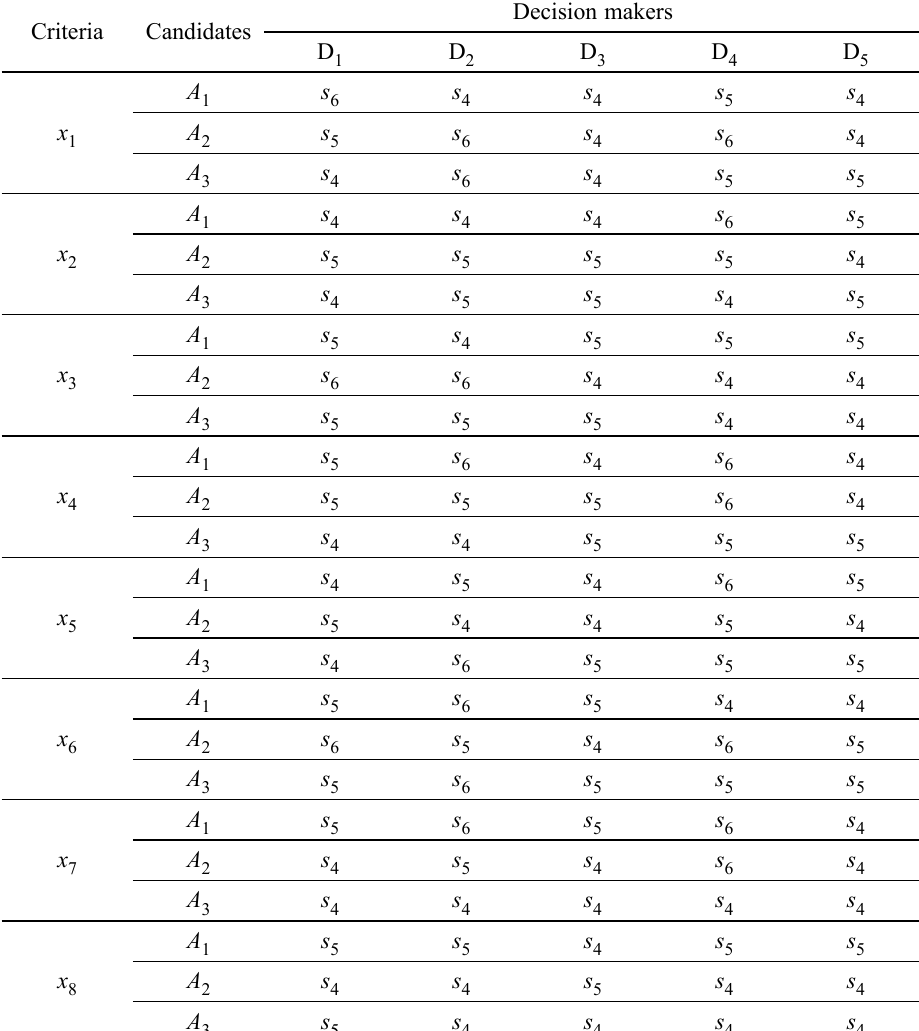
Table 5. Rating of candidates with respect to subjective criteria